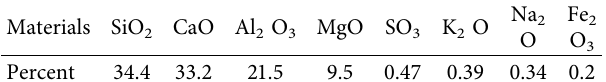
Table 2: GGBS constituents’ chemical composition quantifed in %.